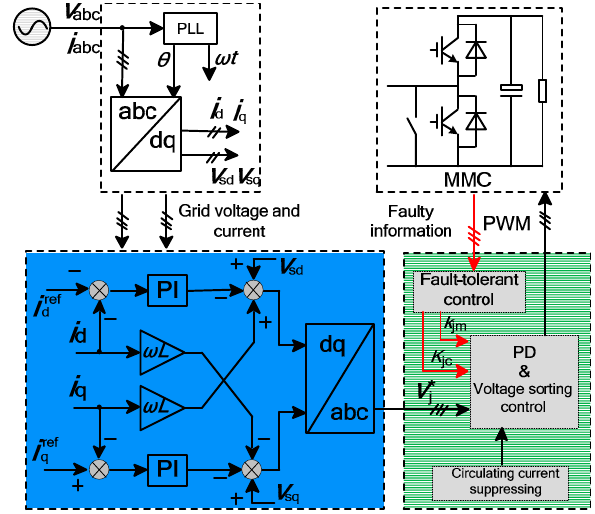
Figure 8. Schematic diagram of control system.